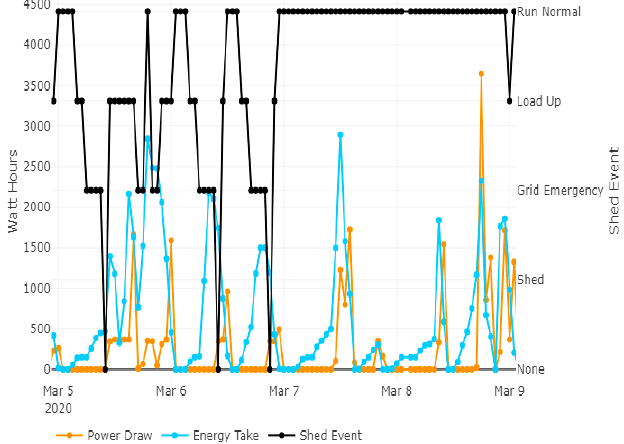
Figure 3. Manufacturer B HPWH behavior 5 – 9 March.